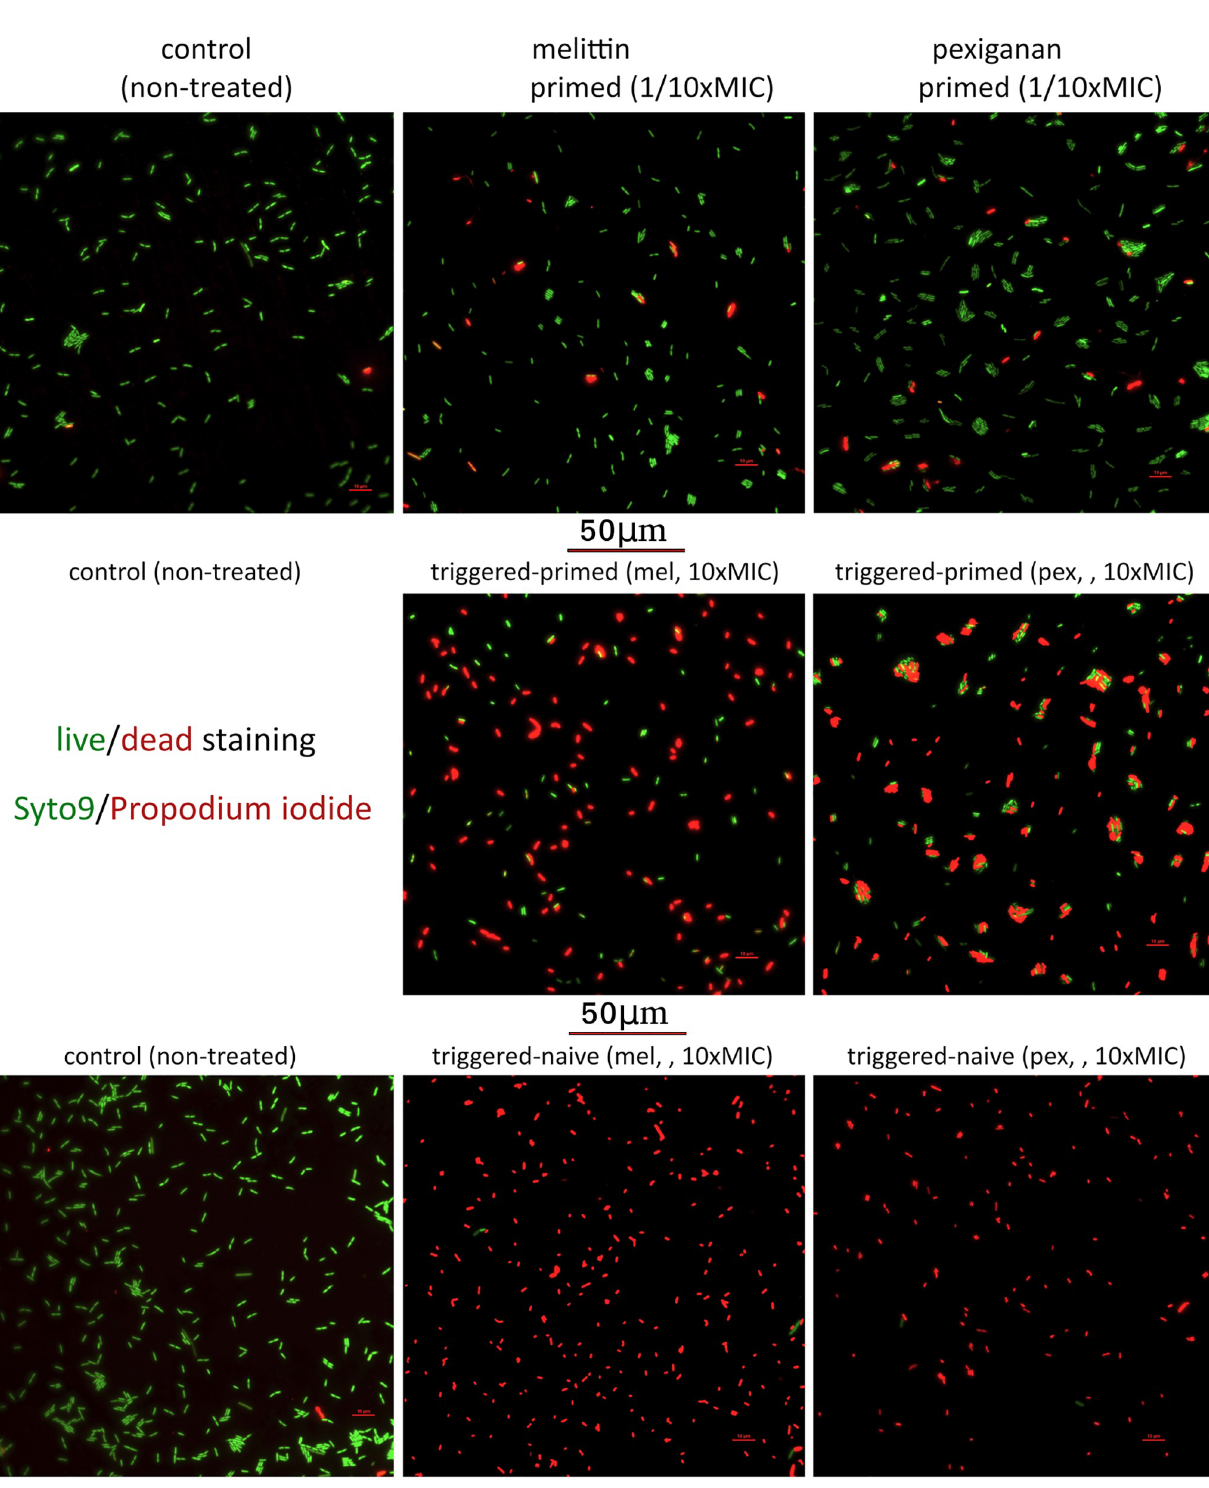
Fig 3. Cell viability after treating with priming and trigger doses of melittin and pexiganan were determined using the live/dead BacLight Bacterial Viability Kit (Thermo Scientific, Germany) on-chip as described in the Material and methods section. After priming during 30 minutes, the treatments were removed by perfusing fresh MHB. The cells were allowed to recover for another 30 minutes and challenged with 10xMIC for 10 minutes. The AMPs were quickly removed by perfusing fresh MHB supplemented with syto9 and propidium iodide. The fluorescence images were acquired as described in the Material and methods